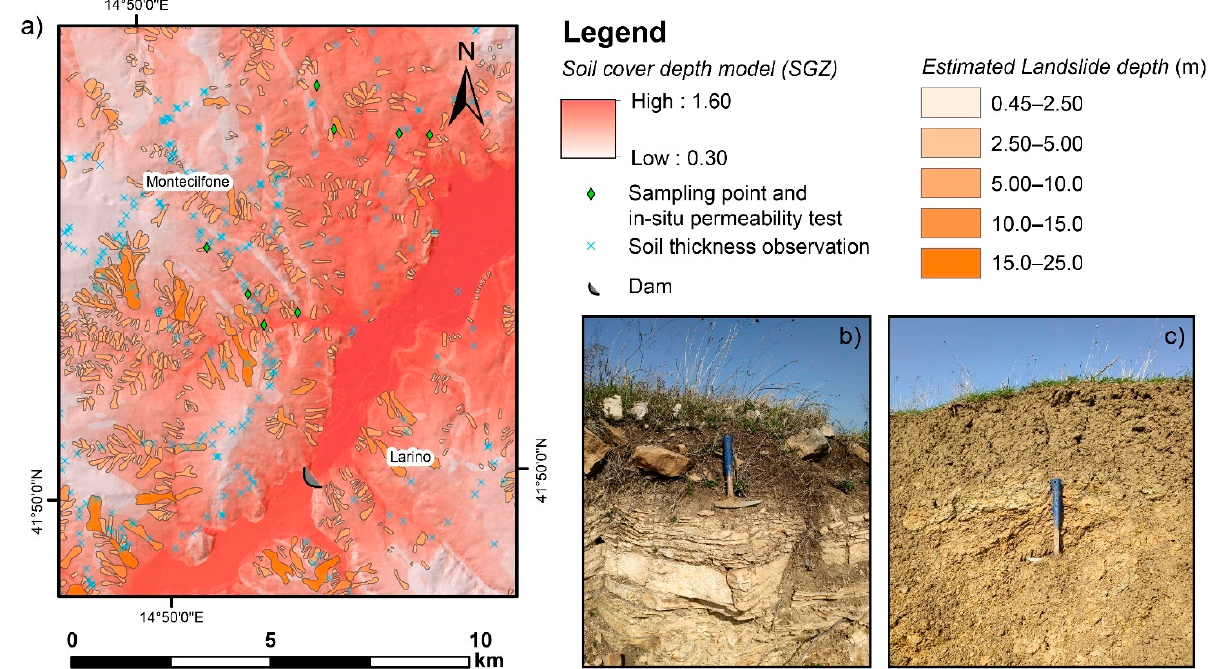
Figure 3. ( a ) Map of the soil cover depth developed according to the SGZ model. Estimated landslide depth, inferred through area vs. volume relationship proposed by Guzzetti et al. [40], is also re- ported. Minimum ( b ) and maximum ( c ) endmembers of weathered soil cover visible in outcrops are